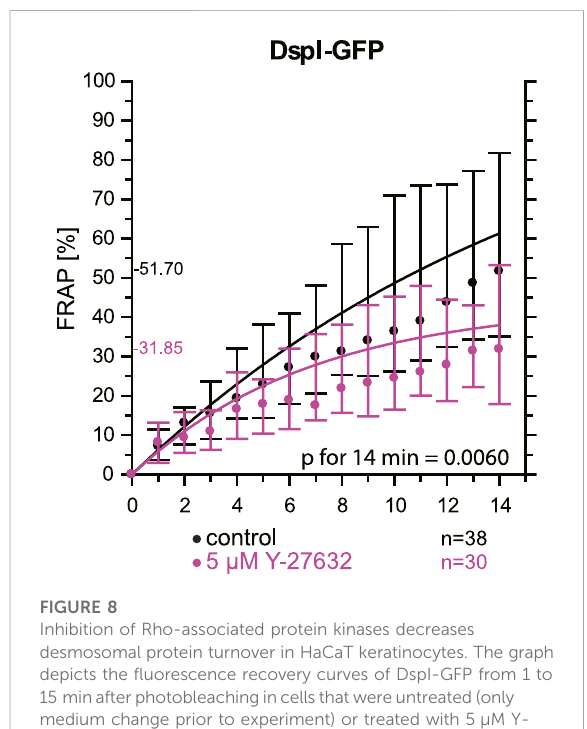
FIGURE 8 Inhibition of Rho-associated protein kinases decreases desmosomal protein turnover in HaCaT keratinocytes. The graph depicts the fl uorescence recovery curves of DspI-GFP from 1 to 15 minafterphotobleachingincellsthatwereuntreated(only medium change prior to experiment) or treated with 5 µM Y- 27632. Dots represent medians, whiskers correspond to the 25 – 75th percentiles, and statistical analysis was performed with a Mann-Whitney test for the last time